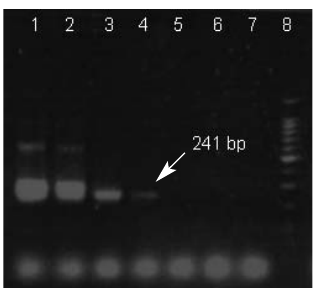
FIG. 2 An agarose gel showing electrophoretic separation of sdn-PCR products obtained from DNA extracted from the blood of bovines infected with AlHV-1 (lane 1), MDBK cell cultures infected with BHV-1 (lane 3), BHV-2 (lane 5), BHV-4 (lane 7), or from an uninfected bovine (lane 9). Samples were also spiked with DNA extracted from a bovine previously shown to be infected with AlHV-1 (from the DNA sample used in lane 1): thus BHV-1 and AlHV-1 (lane 4), BHV-2 and AlHV-1 (lane 6), BHV-4 and AlHV-1 (lane 8), DNA extracted from uninfected bovine and AlHV-1 (lane 10). Lane 2 indicates the product of a neg- ative control sample where the template was replaced with water. Lane 11 contains a DNA size marker com- prising a 100 bp ladder